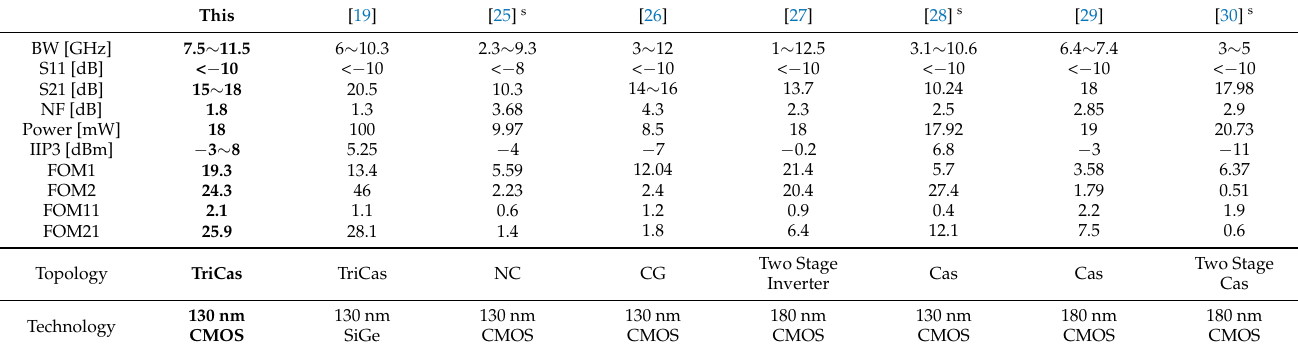
Table 2. Performance comparison with other